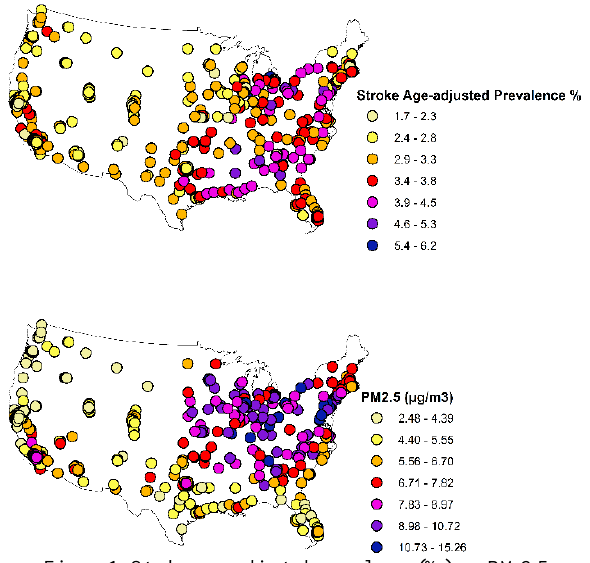
Figure 1. Stroke age-adjusted prevalence (%) vs. PM2.5 (µg/m3), 491 major cities in conterminous USA.